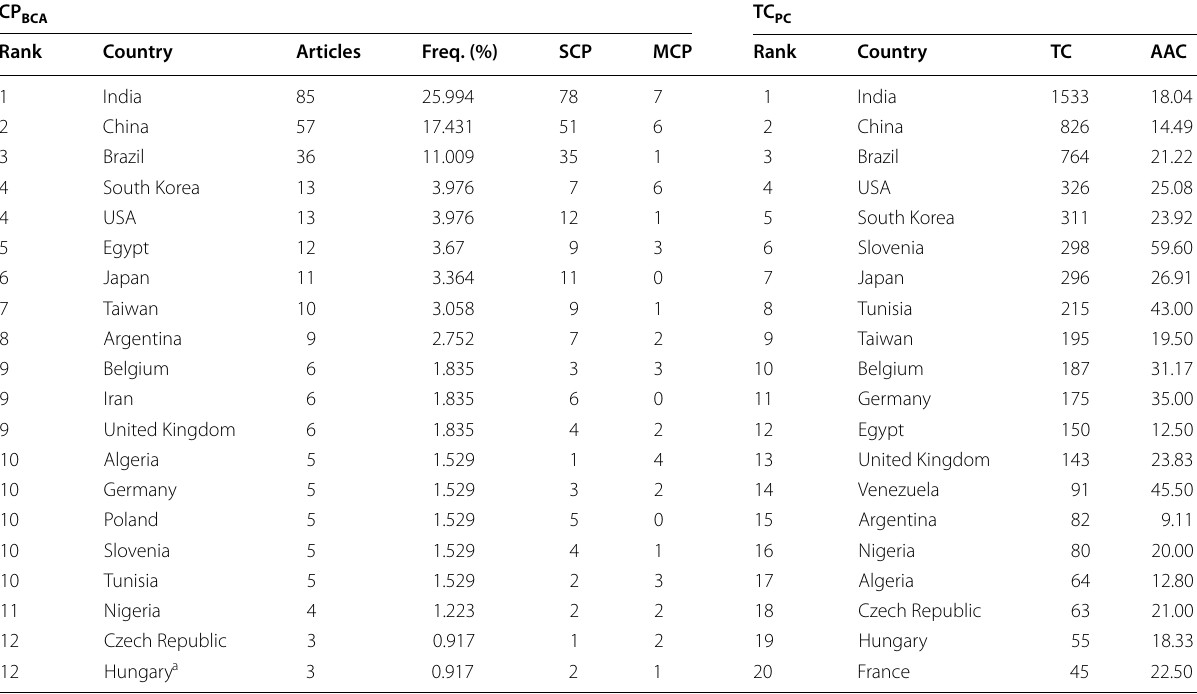
Table 6 The top twenty productive countries on keratinase research based on corresponding authors